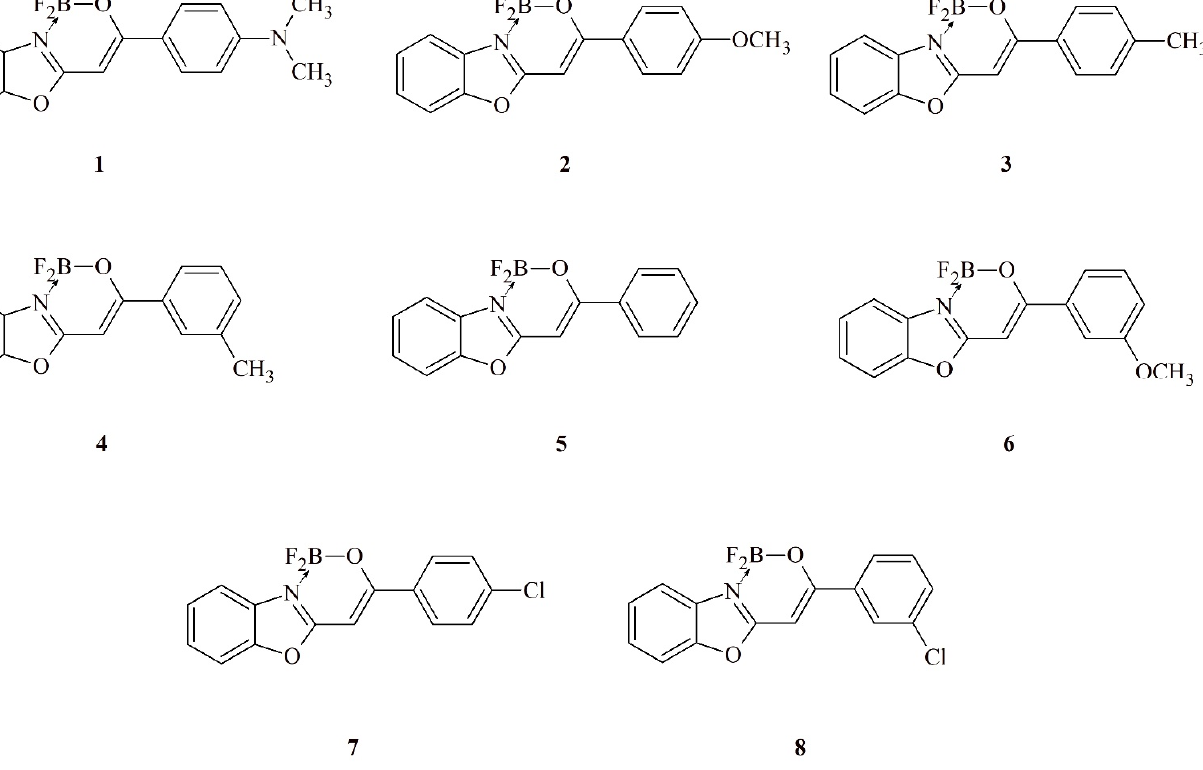
Figure 1. Molecular structure of the prepared 2-phenacylbenzoxazole difluoroboranes. The photoinitiation ability and photochemical properties of different photoinitiating systems were studied in